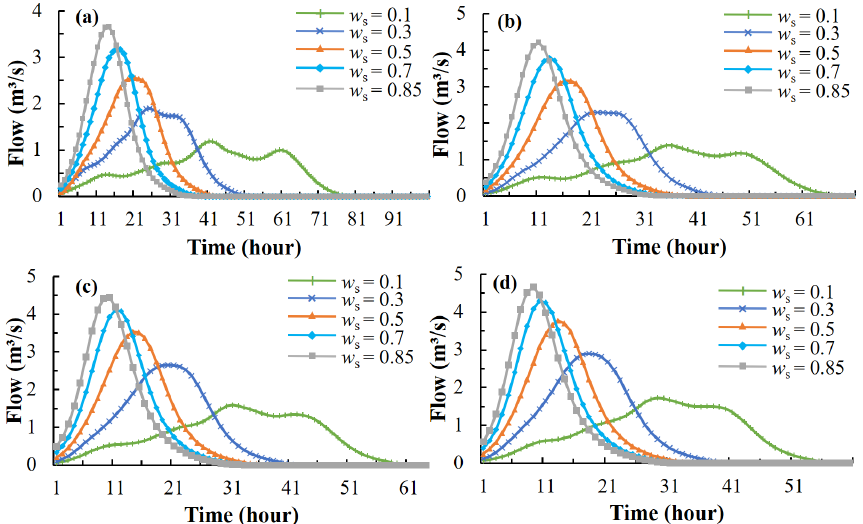
Figure 11. The TDUH considering soil moisture content for sub-basin 1 of the Qin River basin. (a) I s = 0 . 5. (b) I s = 1. (c) I s = 1 . 5. (d) I s =